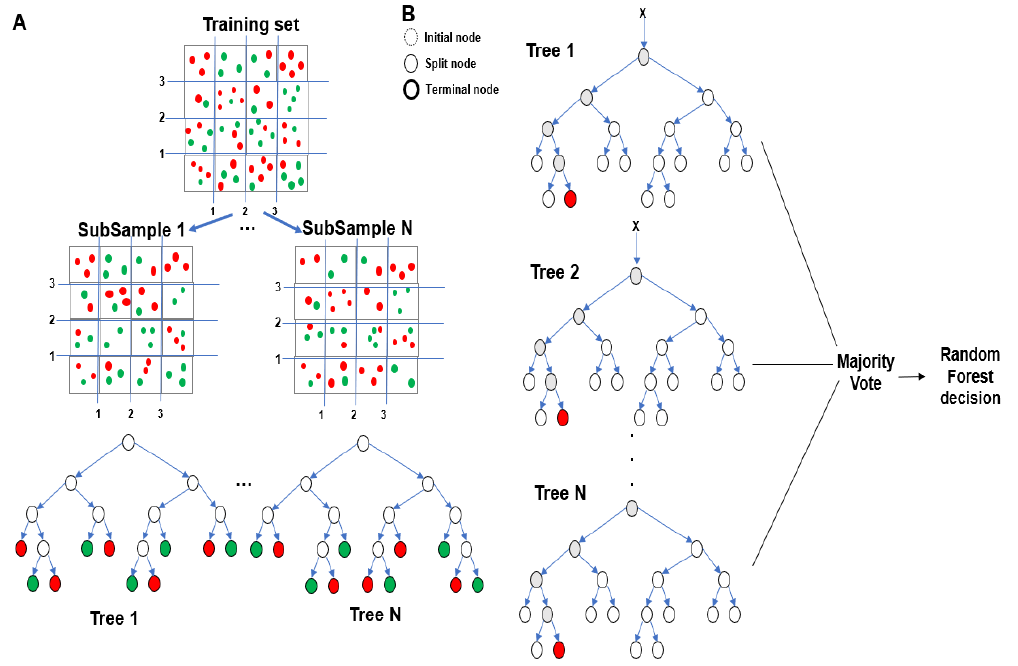
Figure 1. Random Forest (RF) model.